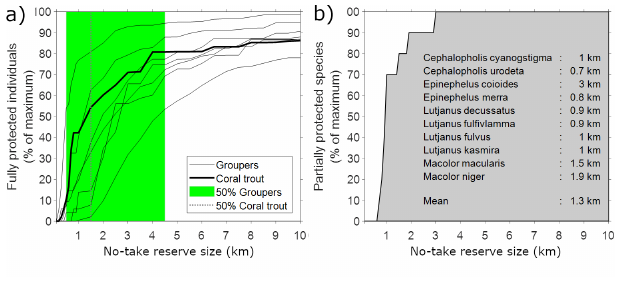
Fig. 4. Fish protection effectiveness in no-take reserves of increasing size. (A) Simulated protection of eight species of well-researched grouper. (B) Regression-based estimate of reserve sizes needed for the partial protection of fished grouper and snapper species observed in Bungaiya, Indonesia. Partial protection means that at least 50% of local individuals range within reserve